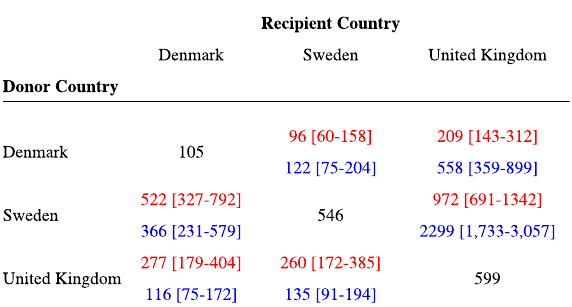
Table 1. COVID-19-attributed deaths per million for the UK, Denmark and Sweden until 1st July 2020. Diagonal elements show observed mortality (black text), off-diagonal elements show mortality (median with 95% credible intervals) for counterfactual scenarios. Top red text in each row denotes counterfactuals estimated using the absolute R t transposition approach. Bottom blue text in each row denotes counterfactuals estimated using the relative R t / R 0 transposition